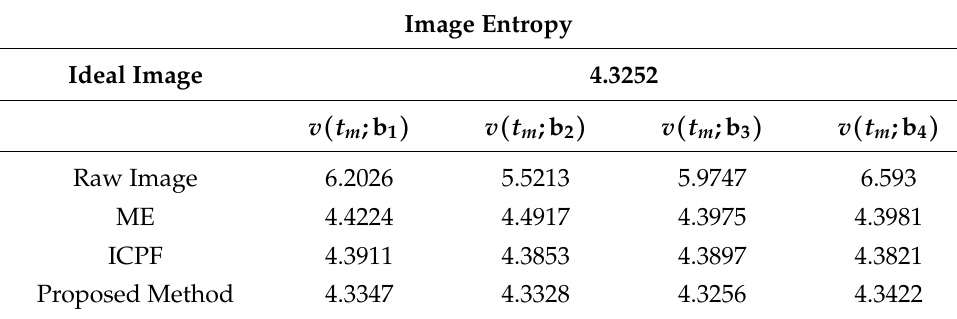
Table 3. The entropy of images acquired by different algorithms.